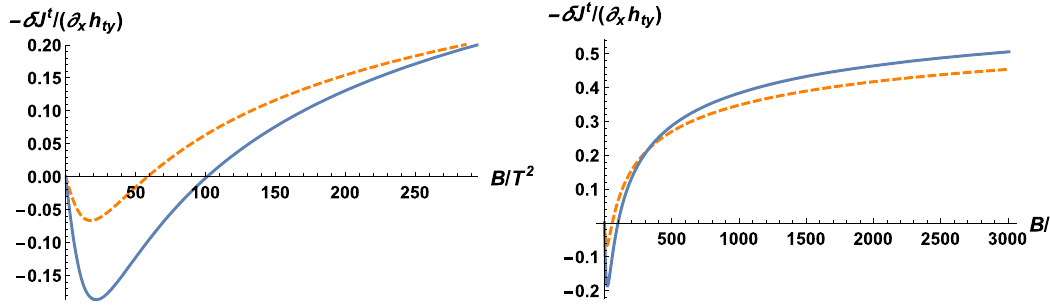
Fig. 4 Theanomalouscorrection (cid:13) δ J t T ty (cid:14) /( iq ) inunitof r 2 for solid